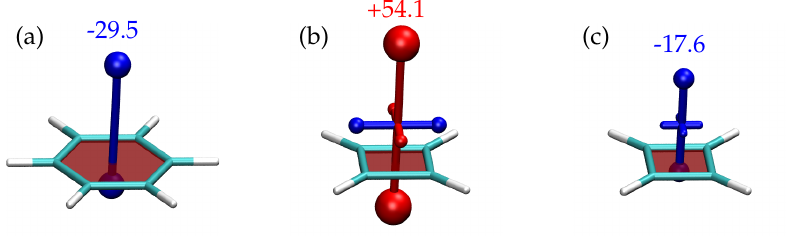
Figure 4. Visualisation of chemical shielding tensors (VIST) for ( a ) the S 0 state of benzene as well as ( b ) the S 0 and ( c ) the T 1 states of cyclobutadiene, all computed 1 Å above the molecular plane. The numbers (given in ppm) correspond to the negatives of the eigenvalues t ( i ) associated to the dominant out-of-plane contributions.